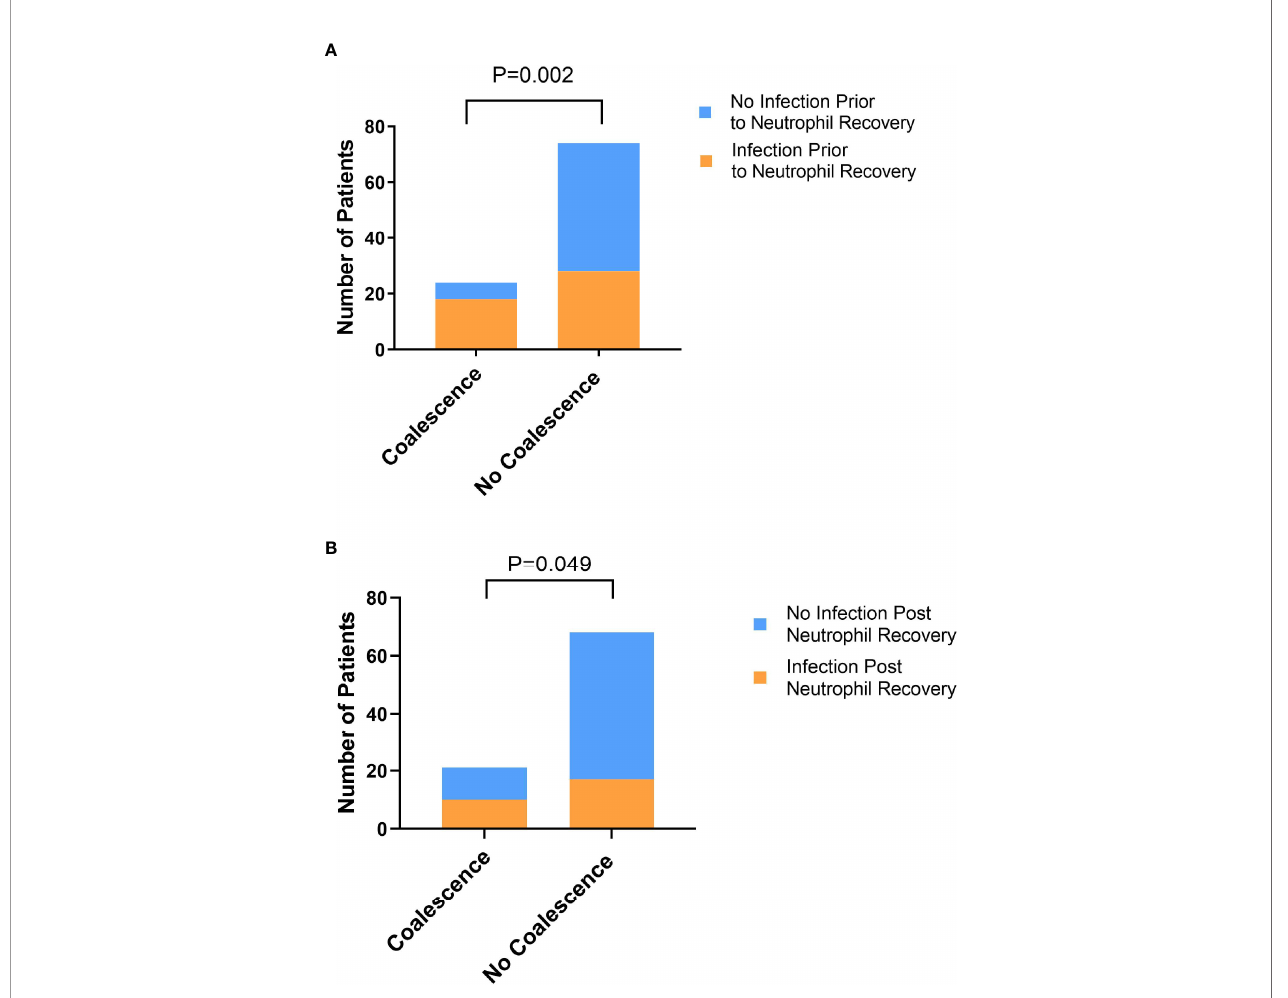
FIGURE 7 | Exhibiting oral-stool community coalescence was associated with the occurrence of infections prior to neutrophil recovery and in the 90 days post neutrophil recovery. Pearson ’ s c 2 test was used to determine whether there was a signi fi cant difference between the frequency of infection prior to neutrophil recovery (A) and in the 90 days post-neutrophil recovery (B) between those who did and did not exhibit oral-stool coalescence during induction